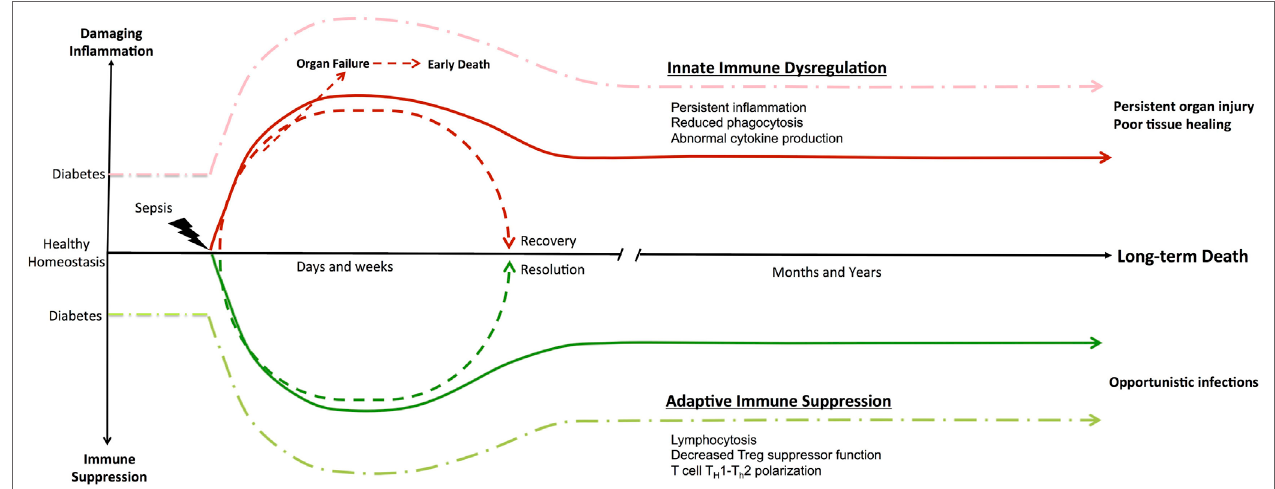
FigURe 1 | Immune dysregulation in Type II diabetes and sepsis. Diabetes is a functional immune deficiency with chronic inflammation and immune suppression that affects an individuals’ overall immune system homeostasis. The development of patient management protocols in sepsis has decreased early organ failure and sepsis mortality, allowing highly comorbid elderly patients to survive the initial insult. Furthermore, sepsis studies have demonstrated an enduring inflammatory state driven by dysfunctional innate and suppressed adaptive immunity that culminates in persistent organ injury and patient death. Subsequently, the highly comorbid elderly patient population that initially survived now experiences significant morbidity and mortality several months to a year later. Multiple hypotheses for these observations exist, with persistent derangements in the innate and adaptive immune system cellular functions as the main contributors to this long-term